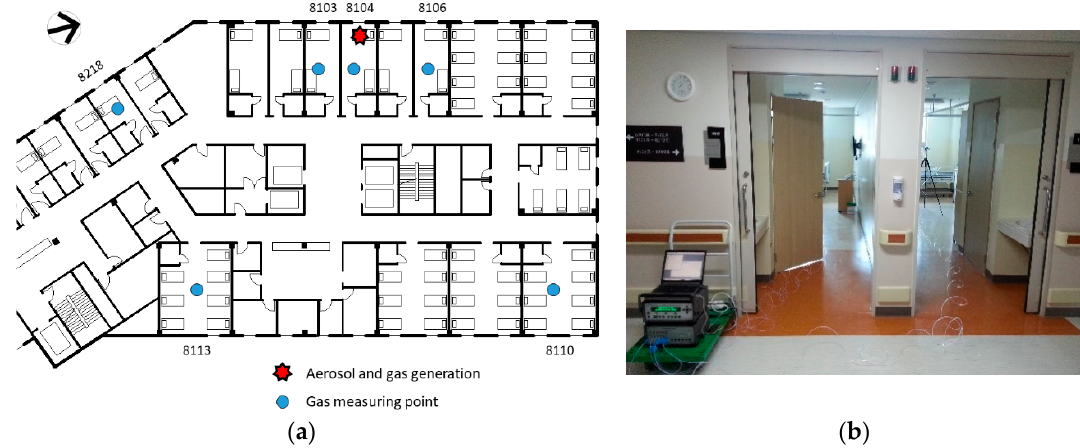
Figure 1. Setup of the tracer experiment using sulfur hexafluoride (SF6) gas: ( a ) dosing and sampling points; ( b ) sliding doors of rooms 8103 and 8104.